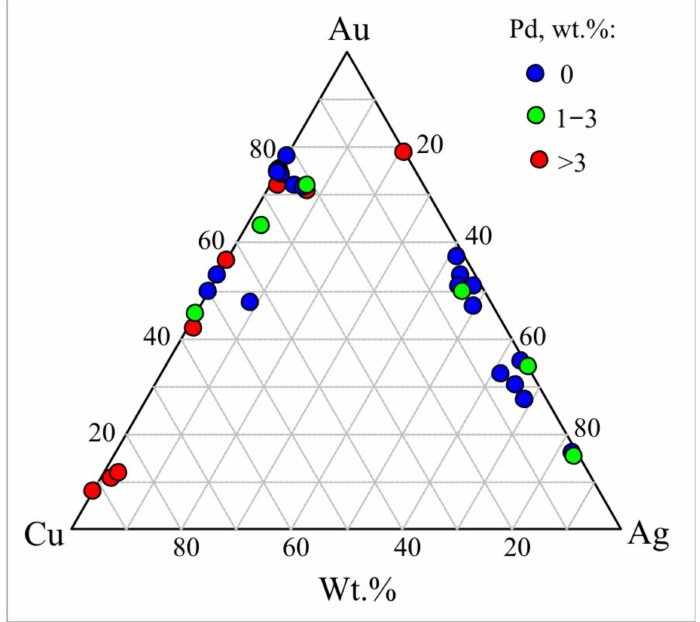
Figure 14. Chemical composition and palladium and copper content of native gold from Ozernoe occurrence on Au-Ag-Cu